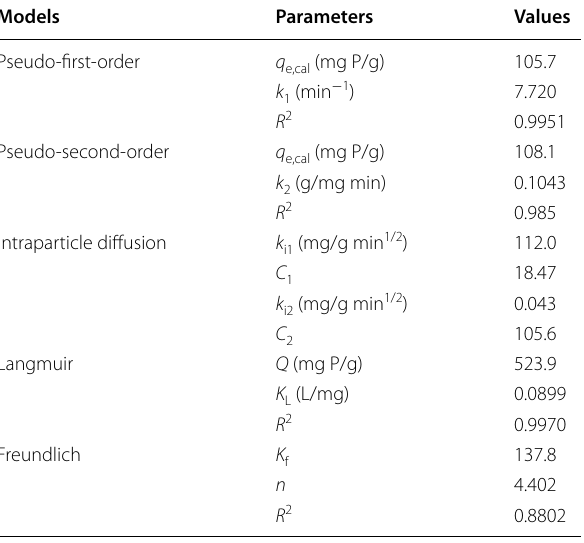
Table 2 Adsorption kinetics and isotherm model parameters obtained from the experiment Models